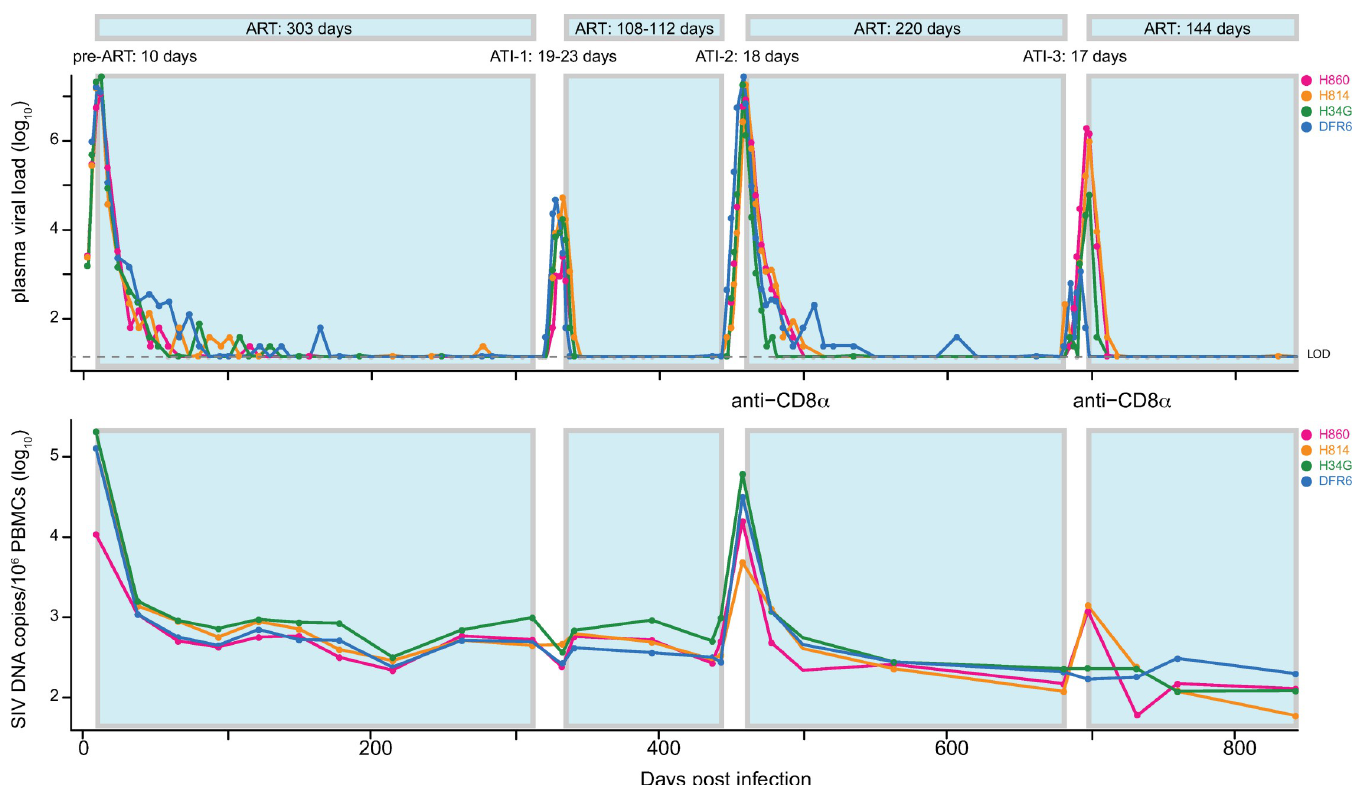
Fig 1. Viral replication dynamics in plasma and PBMC CA-DNA. Four Indian-origin Rhesus macaques were infected with SIVmac239M on day 0 and treated with ART on day 10. Viral RNA (copies per mL) were measured in plasma over 843 days with values below 15 copies/mL shown in grey. The animals underwent three treatment interruptions, between 313 to 336 dpi, 444 to 462 dpi, and 682 to 699 dpi. CD8 depletion with anti-CD8 α mAb was performed 3 days prior to the last two ATIs. CA-vDNA (per 10 6 PBMC) was also quantified via qPCR at various times post